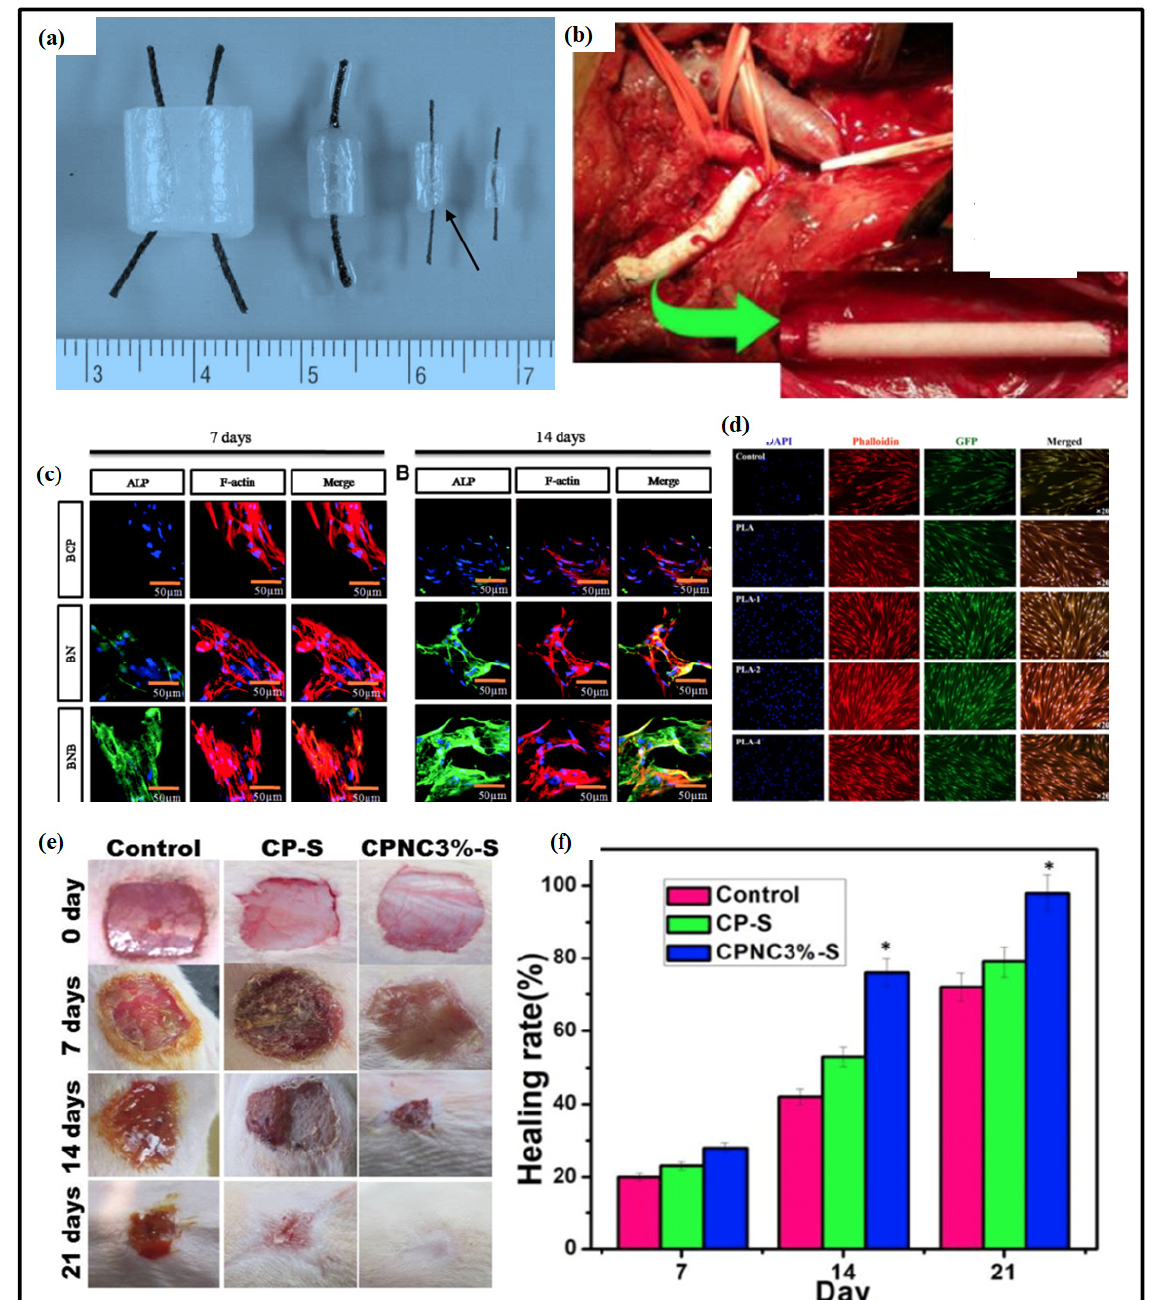
Figure 4. Nanocellulose-based biomedical applications. ( a ) Different sized bacterial synthesized cellulose tubes. Adapted with permission from Ref. [163]. ( b ) Vascular prosthesis implant consisting of polyurethane/nanocellulose for treating multiple endocrine neoplasia 2B. Adapted with permission from Ref. [183]. ( c ) Confocal micrograph of localization of ALP protein (green) in RBM- SCs after treatment with nanocellulose-based scaffold for 7 and 14 days to assess the effect of VEGF and BMP2 growth factors. ( d ) Fluorescence microscopy images of bMSCs growing on chitosan/CNC nanofibers. Adapted with permission from Ref. [184]. ( e ) Images of wound treated with control, CP-S (Chitosan/polyvinyl pyrrolidone-stearic acid), and CPNC 3% (Chitosan/polyvinyl pyrrolidone/nanocellulose-stearic acid 3%). ( f ) The wound healing rate of control, CP-S, and CPNC3%-S bio-nanocomposite. * Considerably difference compared to the control group ( p < 0.05). Adapted with permission from Ref.